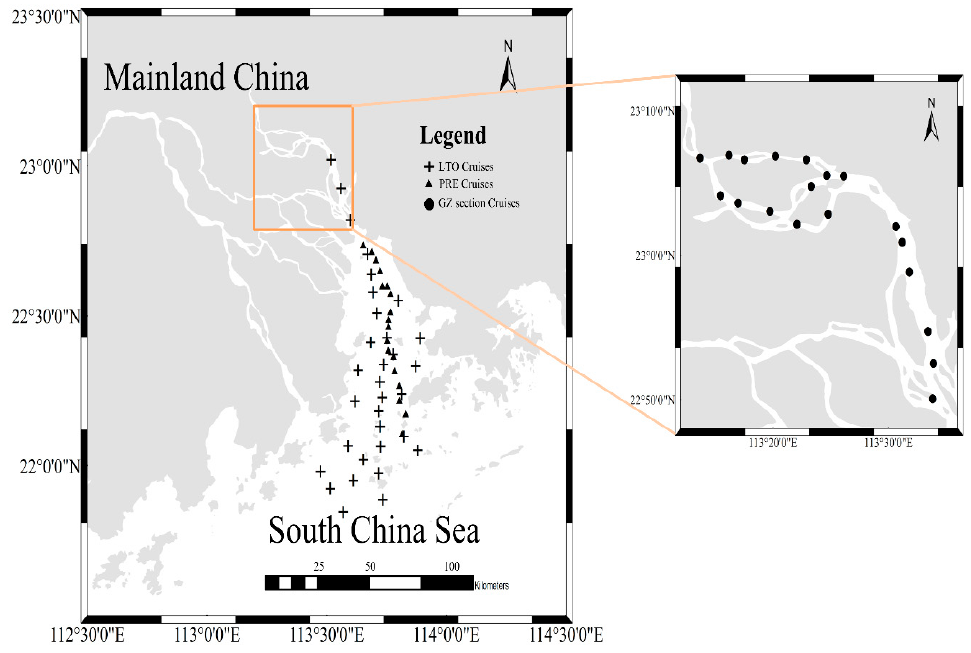
Figure 2. The sample stations of the three cruise routes used in this study; the plus sign represents the LTO cruise stations, the triangles represent the stations of the Pearl River Estuary cruises, and the solid circles represent the stations of Guangzhou Section cruises.